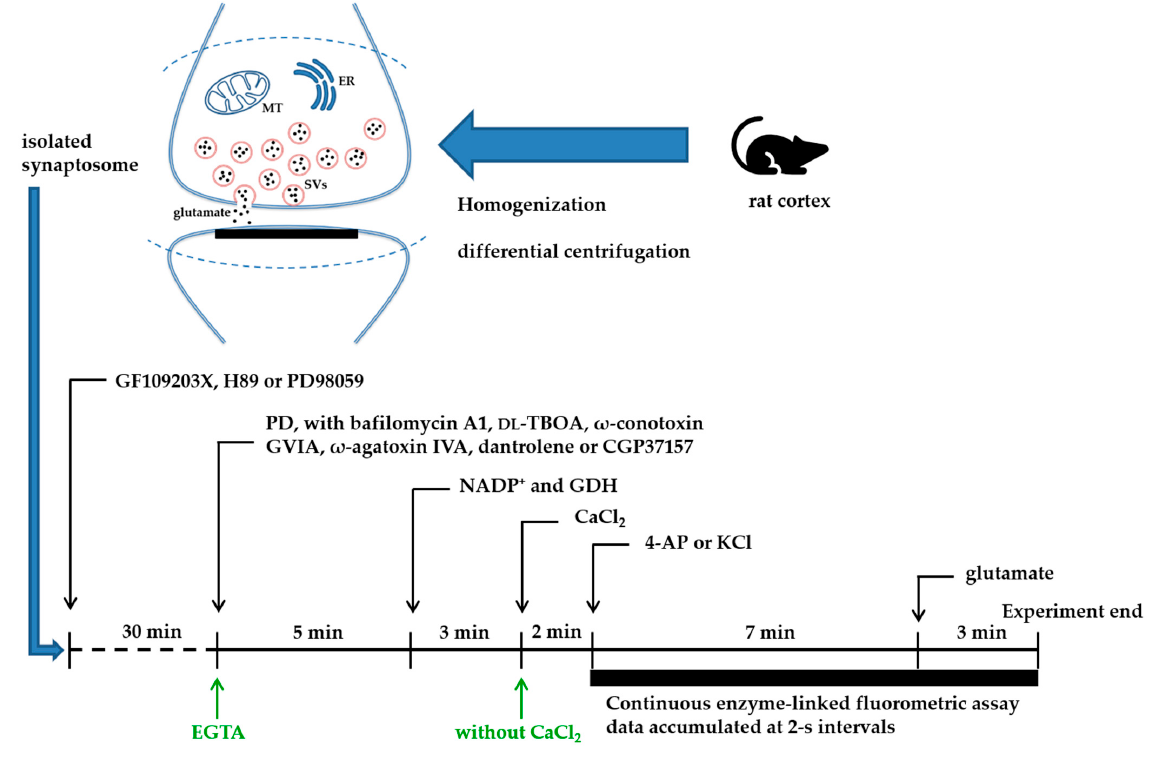
(Figure 2B). The inhibitory effects of PD on 4-AP-induced glutamate release are evident down to 5 µM, while maximum inhibition occurs at 50 µM. The half-maximal inhibitory concentration (IC 50) value for PD was 32 µM.